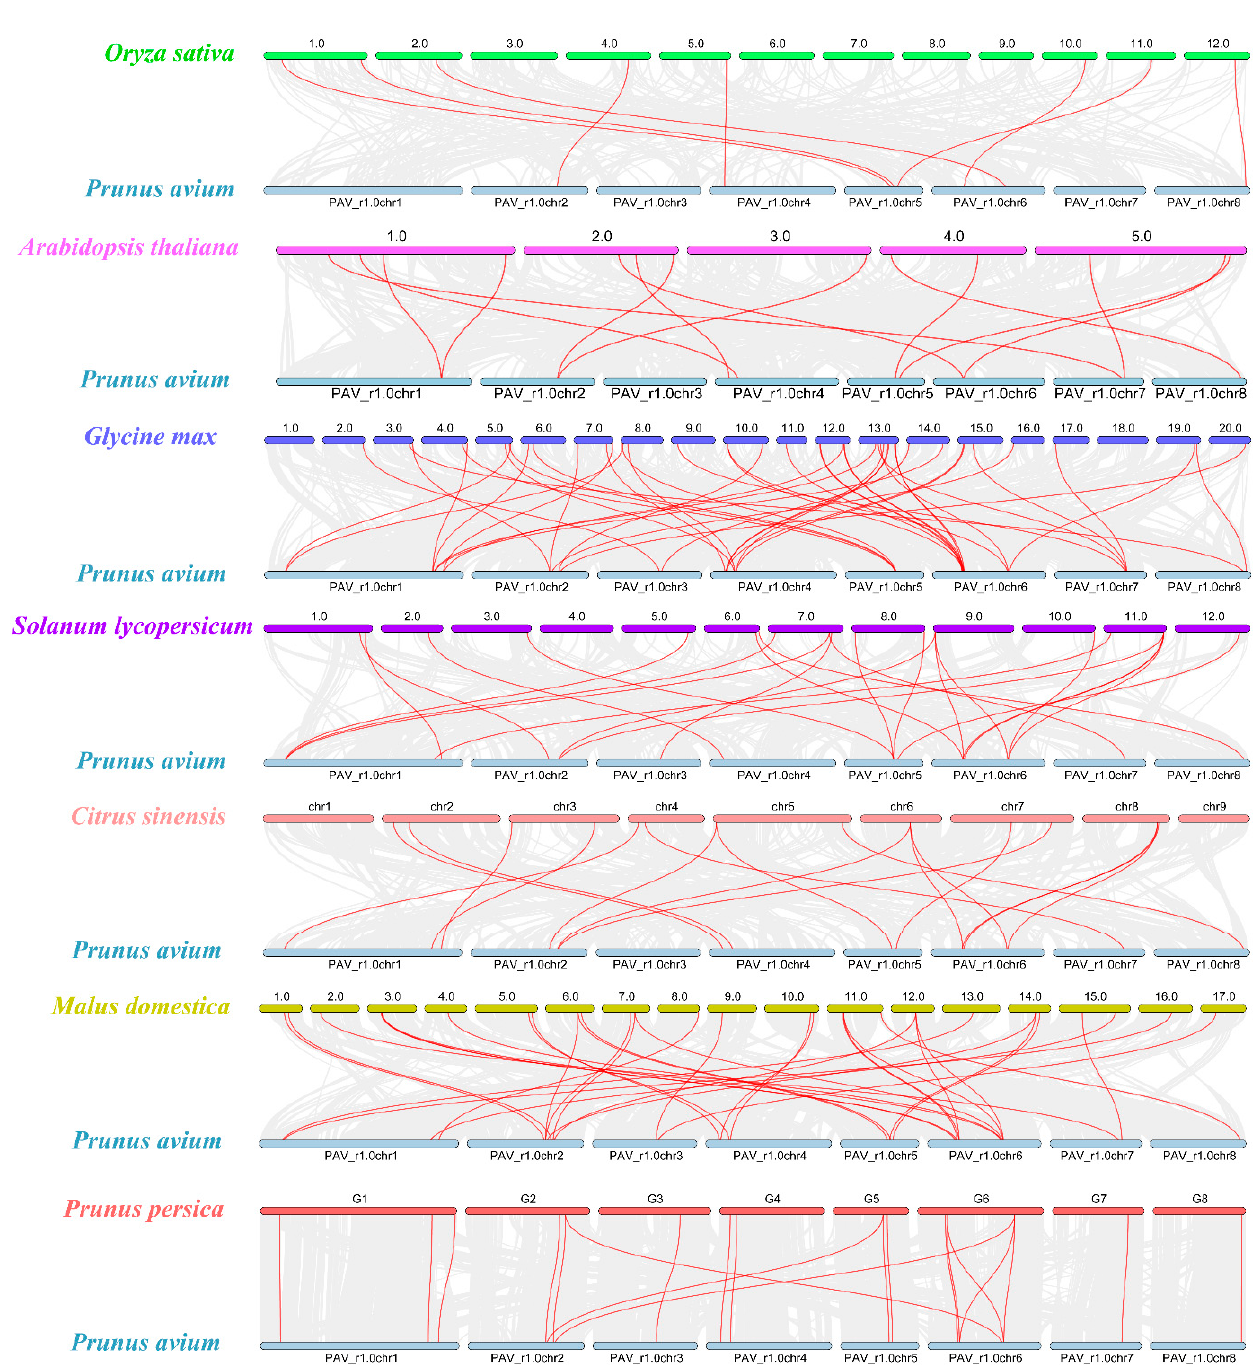
Figure 4. Collinearity analyses of ARF genes between Oryza sativa , Arabidopsis thaliana , Glycine max , Solanum lycopersicum , Citrus sinensis , Malus domestica and Prunus persica . Gray lines in the background indicate the collinear blocks within the Prunus avium and other plant genomes, while the red lines highlight the syntenic ARF gene pairs. Different species are marked with different colors, and sweet cherry is marked with light blue.